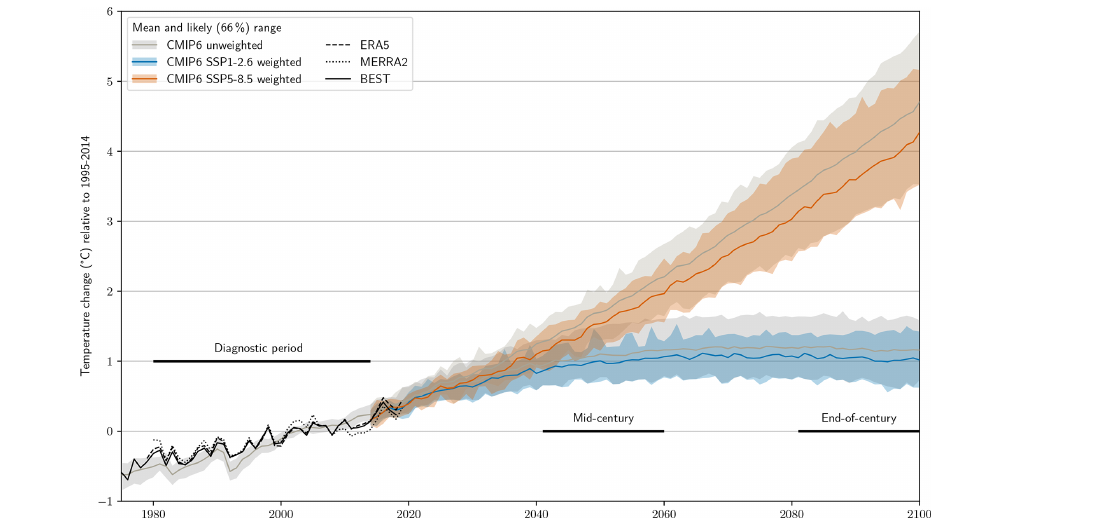
Figure 7. Time series of temperature change (relative to 1995–2014) for the unweighted (gray) and weighted (colored) CMIP6 mean (lines) and likely (66%) range (shading). Three observational datasets are also shown in black; note that BEST is not used to inform the weighting and is only shown for comparison here.